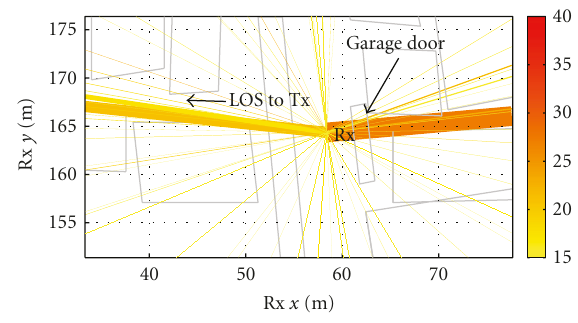
Figure 20: XPR MS